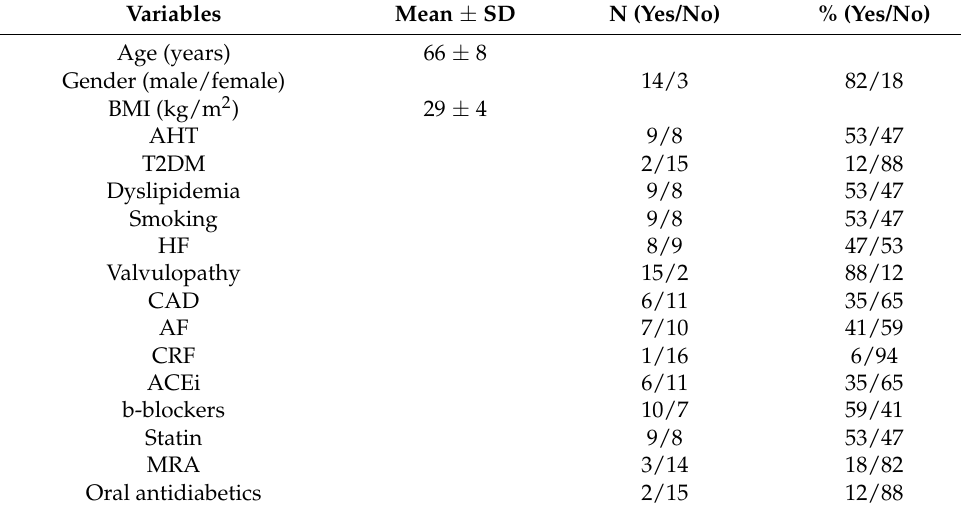
Table 1. Clinical characteristics for primary culture adipogenesis assays.